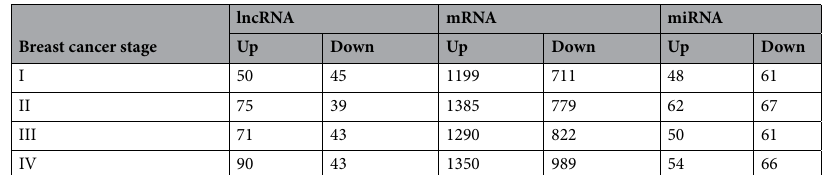
Table 1. Counts of differentially expressed (up/down) lncRNAs, mRNAs, and miRNAs in each BC stage. lncRNA long non-coding RNA, mRNA messenger RNA, miRNA microRNA, Up up-regulated, Down down- regulated.